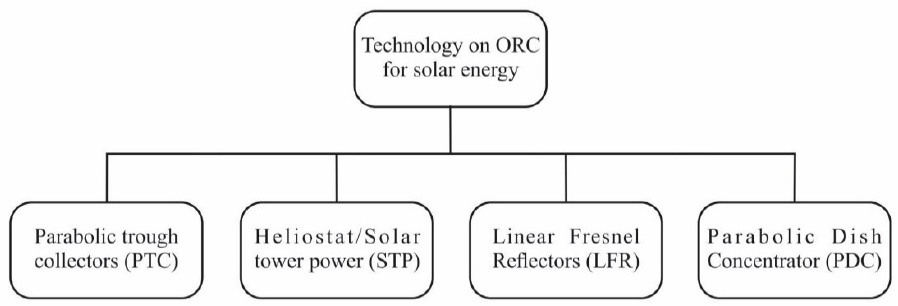
Figure 2. Technologies of organic Rankine cycle application for solar energy.